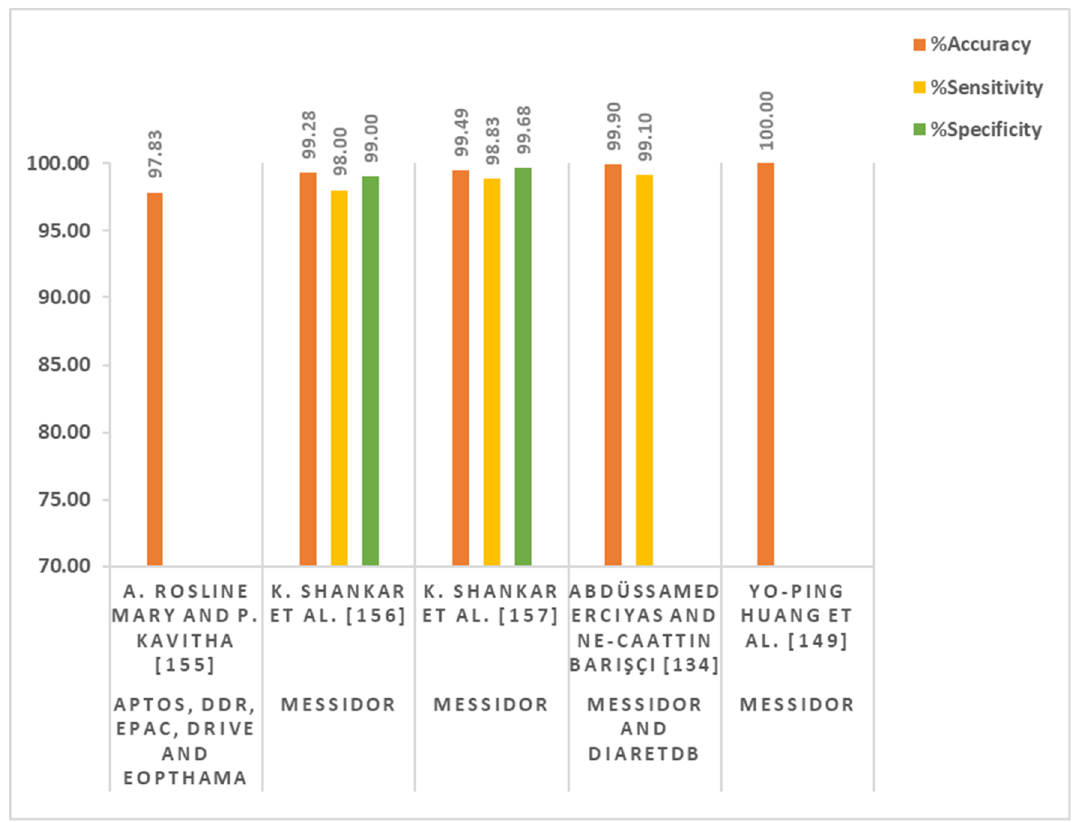
Figure 6. Top 5 publications reporting the best performance for the classification.